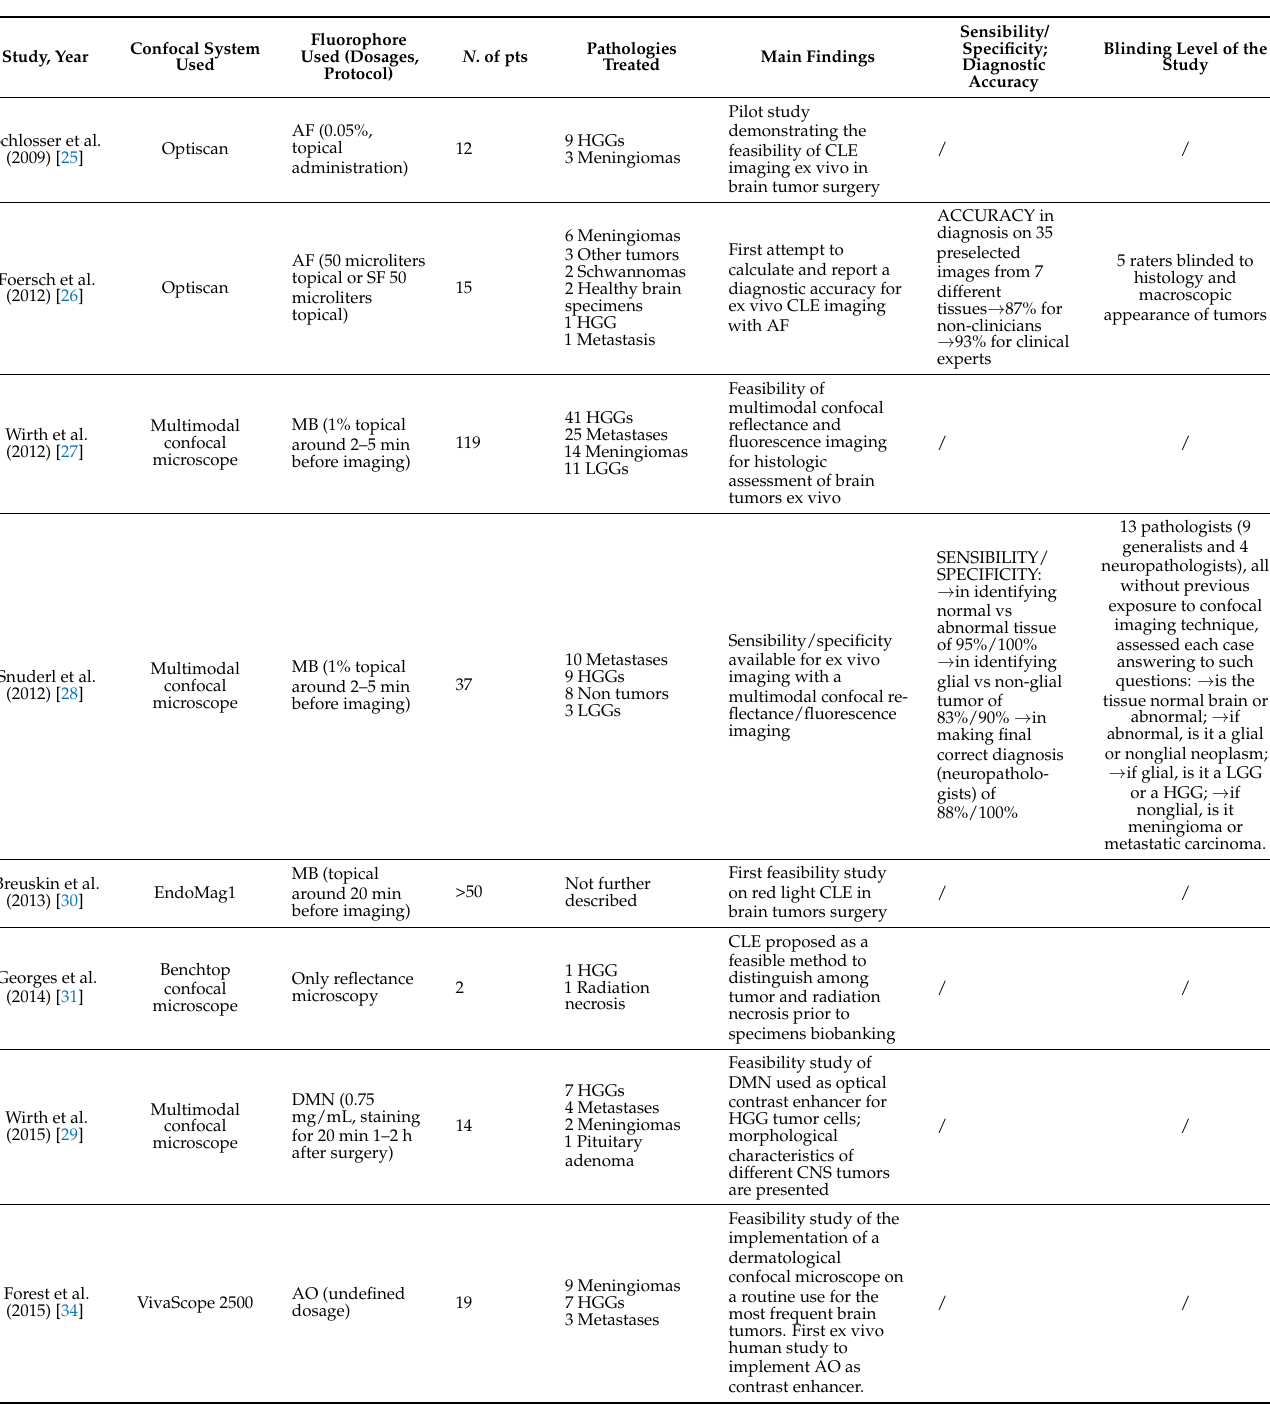
Table 2. Ex vivo experiences (21 works). Legend to the table: AO: acridine orange; CLE: confocal laser endomicroscopy; CV: cresyl violet; DMN: demeclocycline; HGGs: high-grade gliomas; ICG: indocyanine green; iv: intravenously; LGG: low-grade gliomas; MB: methylene blue; OR: operating room; PpIX: protoporphyrin IX; SF: sodium fluorescein; 5-ALA: 5-aminolevulinic